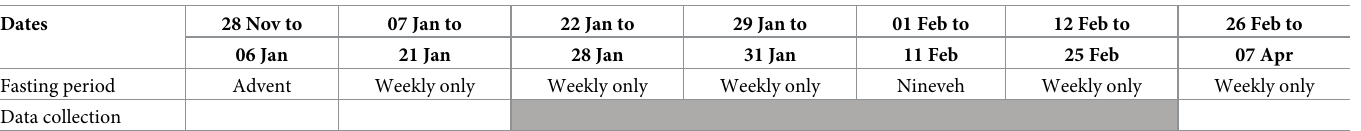
Table 2. Timing of fasting periods and data collection, 2017 and